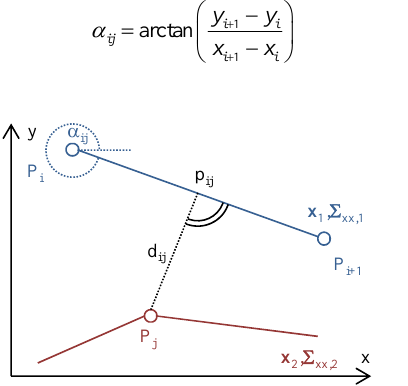
Figure 1 . Geometric dependency between two line features During the LSA P j and P i P i+1 are moved to a common straight line. The scale of the adjustment depends on the number and distribution of the perpendiculars, as well as the stochastic model of